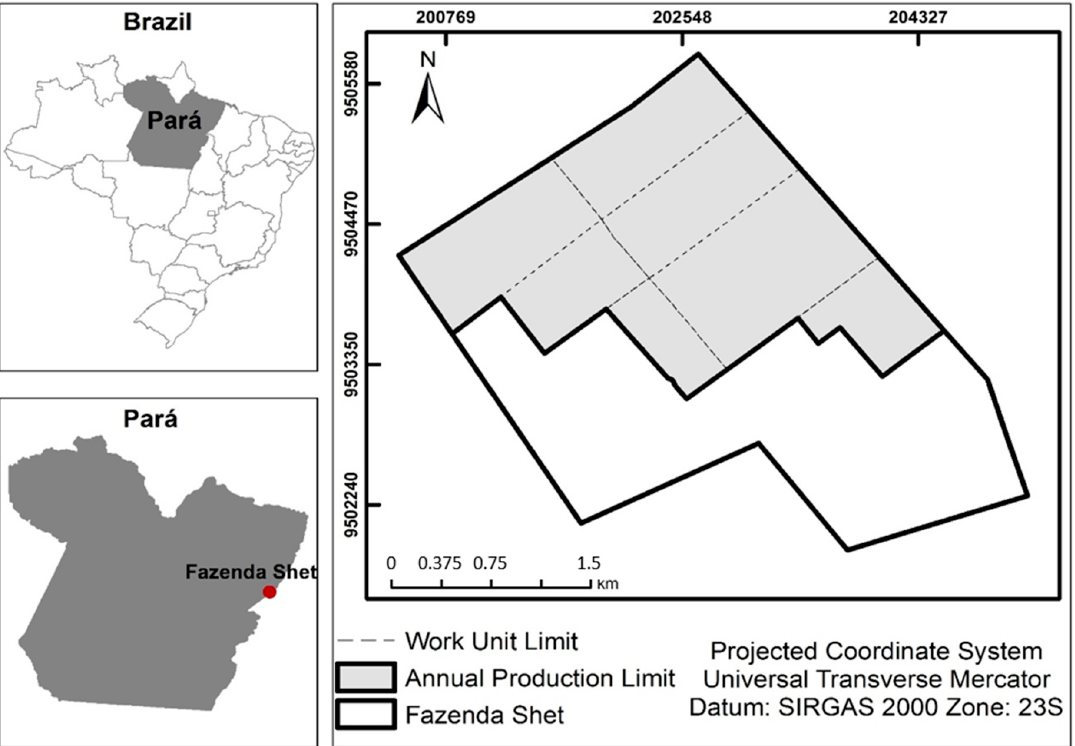
Figure 1. Location and description of Shet Farm, Dom Eliseu, Pará, Brazil.